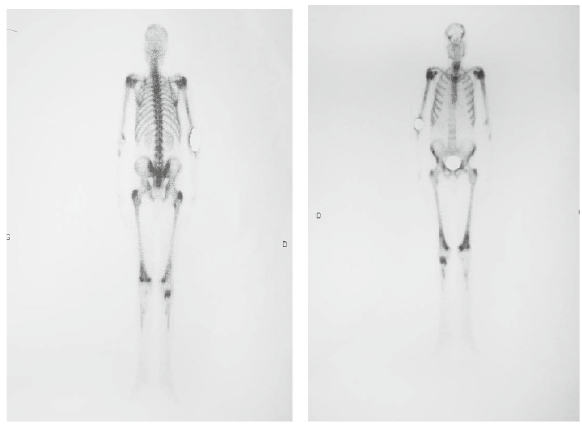
Figure 4: Objective bone scan of many secondary metastatic